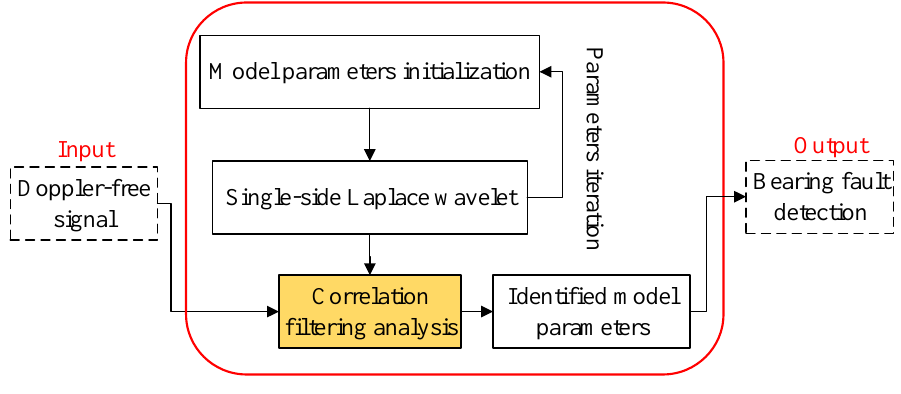
Figure 8. Procedure of the transient model analysis